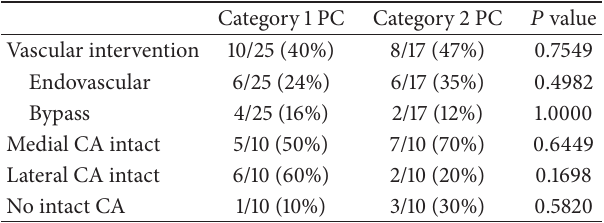
Table 2: Vascular interventions and angiography